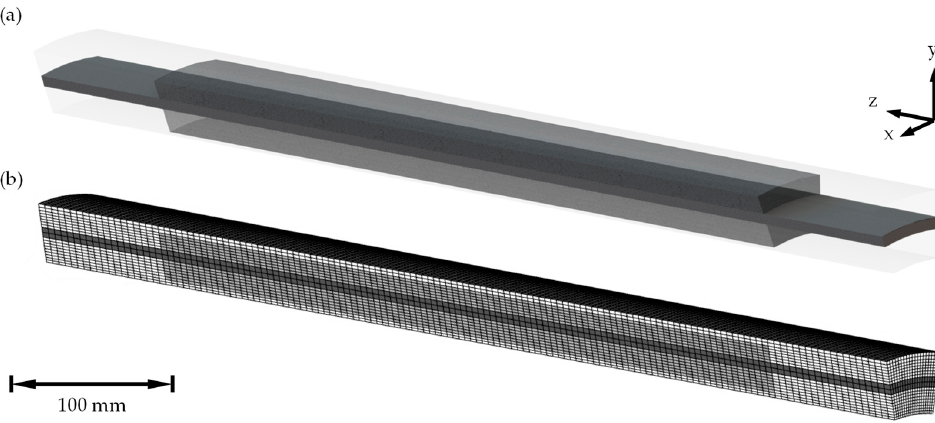
Figure 12. Geometry ( a ) and mesh ( b ) used for the simplified model.